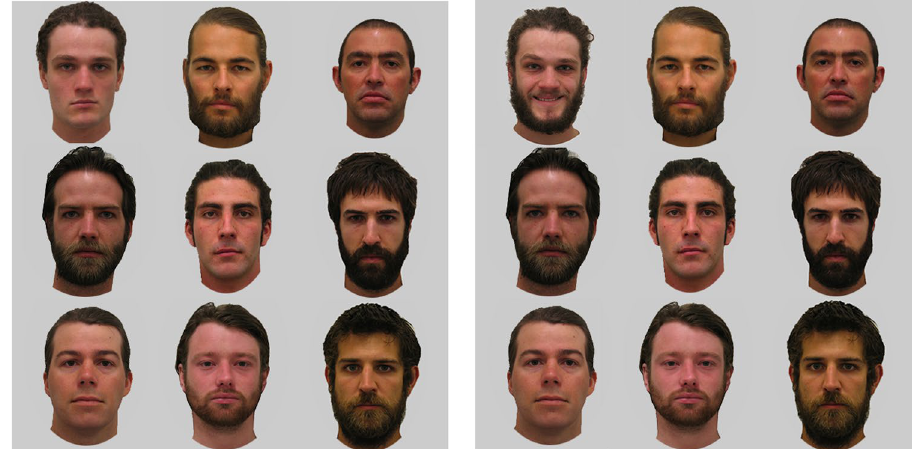
Figure 4. Example of two arrays from trials in Study 2. (Left array) Non-target trial containing uniformly neutral expressions with a mix of bearded and clean-shaven background faces. (Right array) A target trial containing a happy bearded face (top left face) in a mix of neutral bearded and clean-shaven background